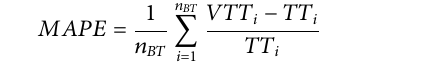
Frontiers in Future Transportation |